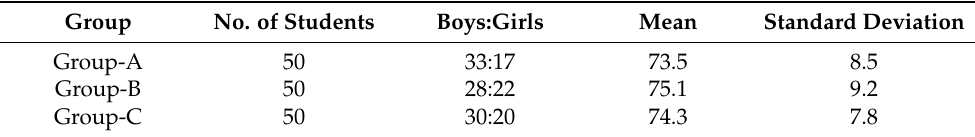
Table 1. Groups arrangement based record of the previous academic grades of the participants in their academic sessions.